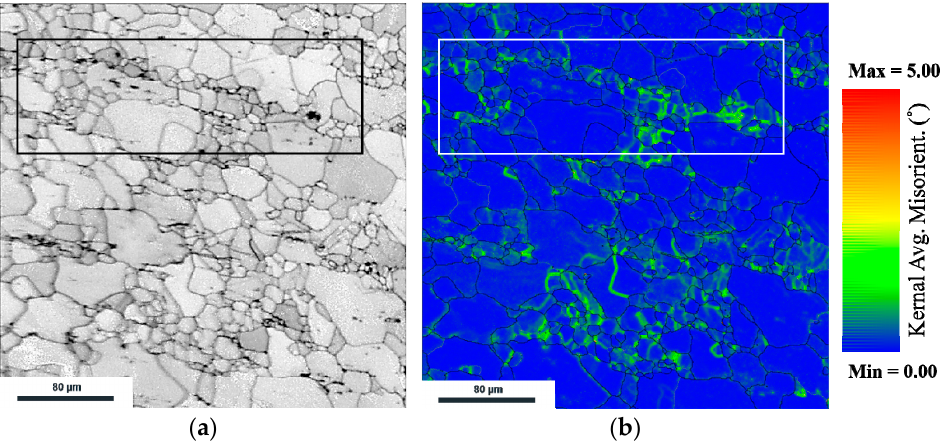
Figure 7. The ( a ) band contrast image and ( b ) KAM map of AZX611 specimen shown in Figure 5c.